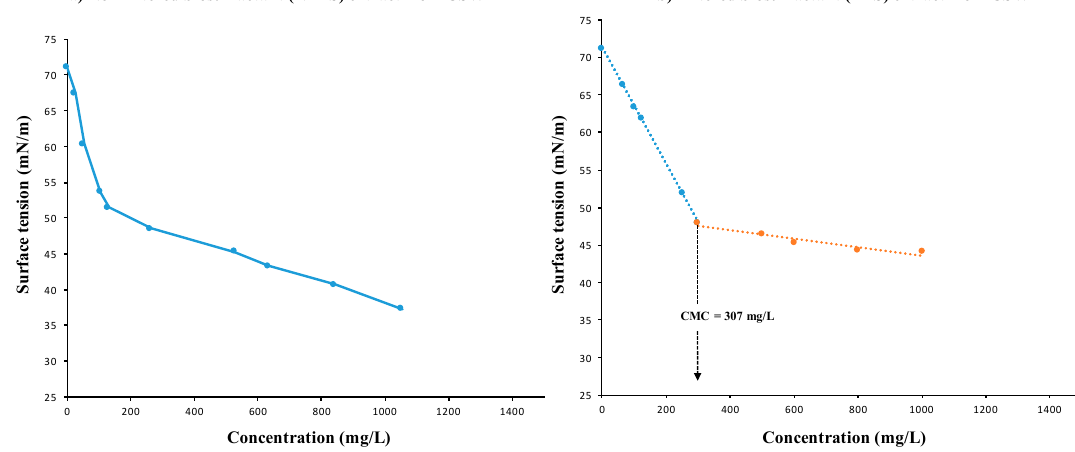
Figure 1. Relationship between the surface tension and biosurfactant concentration ( a ) before (NFBS) and ( b ) after (FBS) a filtration stage. CMC, Critical micellar concentration; CSW, corn steep water. Additionally, Fourier-transform infrared spectroscopy (FTIR) was used to determine the possible similarities and di ff erences between the NFBS and FBS extracted from CSW. The spectra of the NFBS and FBS are showed in Figure 2. It can be observed a strong similarity between both extracts, although − 1 FBS showed higher intensity in the band from 3500 to 3100 cm as the result of N-H and O-H stretching − 1 indicative of amine and hydroxyl groups. Moreover, in the band from 3000 to 2800 cm it can be observed the same intensity for both extracts, indicating the presence of aliphatic chains. In addition, − 1 a strong absorption for both extracts was observed also in the band from 1800 to 1600 cm , resulting of C = O stretching. The C-O ester groups were also confirmed by the presence of various bands from − 1 1300 to 1000 cm , which was in concordance with previous publications [3].